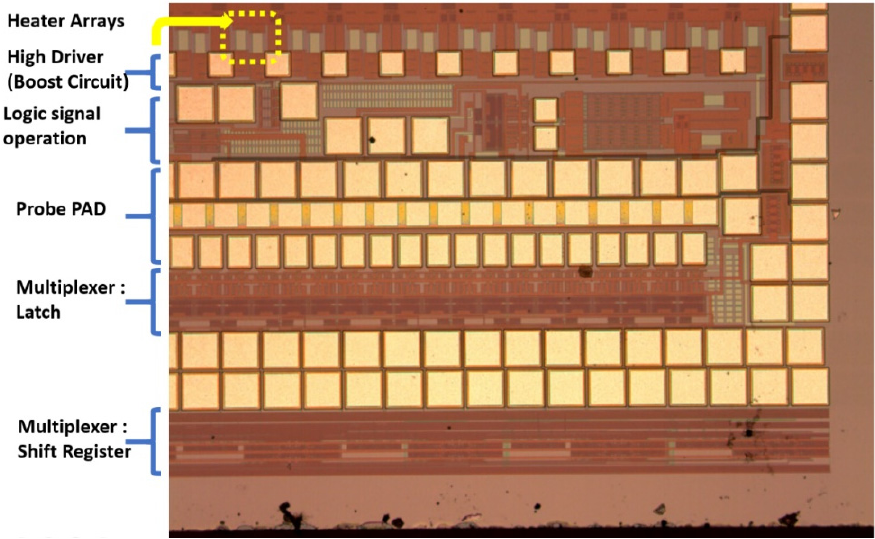
Figure 7. The DNA printing integrated multiplexer driver MEMS head (IDMH).